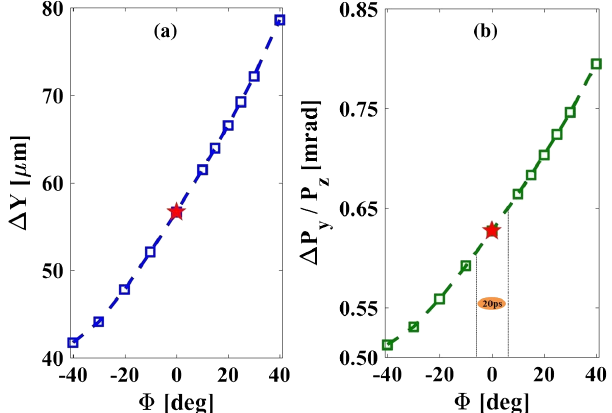
quantification.FIG. 5. Vertical displacement at z ¼ 0 . 3 m and kick strength as a function of the gun phase. Note that 0 degree on both horizontal axes corresponds to the gun phase for the